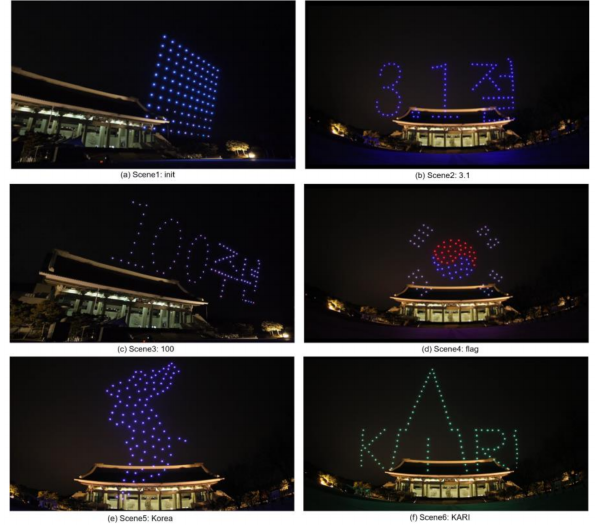
Figure 19. Drone show